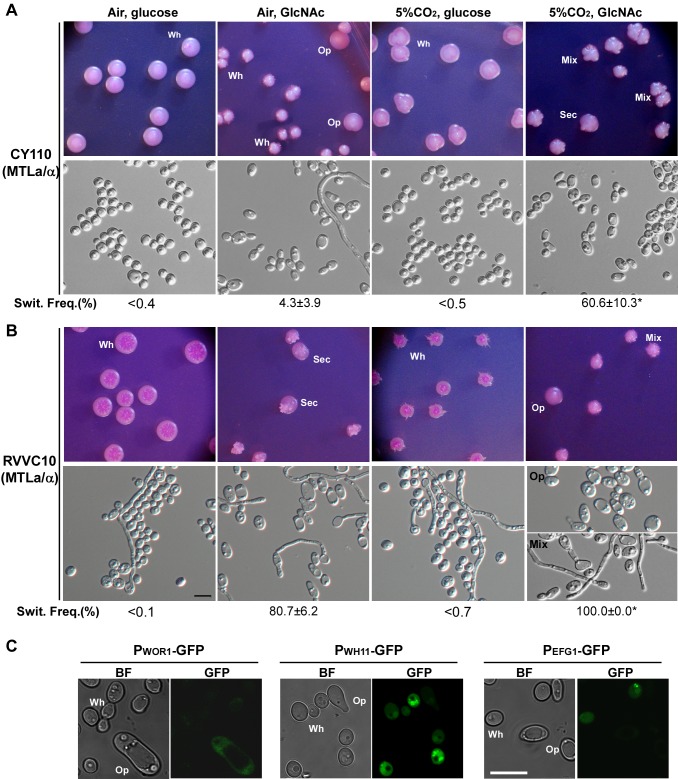
White-to-opaque switching in natural MTLa/α strains of C. albicans at 37°C.White cells of two MTL
a/α strains (CY110 and RVVC10) were plated onto Lee's glucose and Lee's GlcNAc medium plates and cultured in air or 5% CO2 at 37°C for 3 to 4 days. At this temperature, white cell colonies containing filamentous swollen cells could be stained red. Cellular morphologies were examined to confirm the cellular phenotypes. *, the switching frequencies (% of average ± SD) of these samples represented the percentages of colonies containing opaque cells, including opaque, opaque-sectored, and white-opaque mixed colonies. Swit. Freq., switching frequency. Wh, white cells/colonies. Op, opaque cells/colonies. Scale bar, 10 µm. (A) White-to-opaque switching of CY110 at 37°C. (B) White-to-opaque switching of RVVC10 at 37°C. (C) Expression of GFP in the reporter strains of WOR1/WOR1::WOR1p-GFP, WH11/WH11::WH11p-GFP, and EFG1/EFG1::EFG1p-GFP. The parent strain of these strains was CY110 (MTL
a/α). Opaque-sectored colonies grown on Lee's GlcNAc medium plates (without phloxine B) were microscopically examined. BF, bright field.